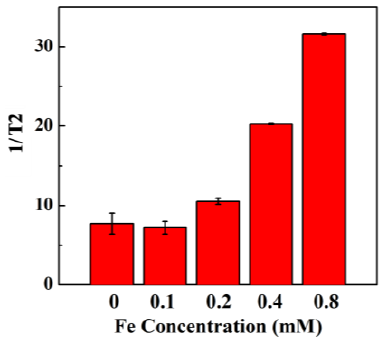
Figure 4. The 1/T2 value of TC-1 cells after treated with PBS, Fe 3 O 4 modified NEs at different Fe concentrations for 15 min.